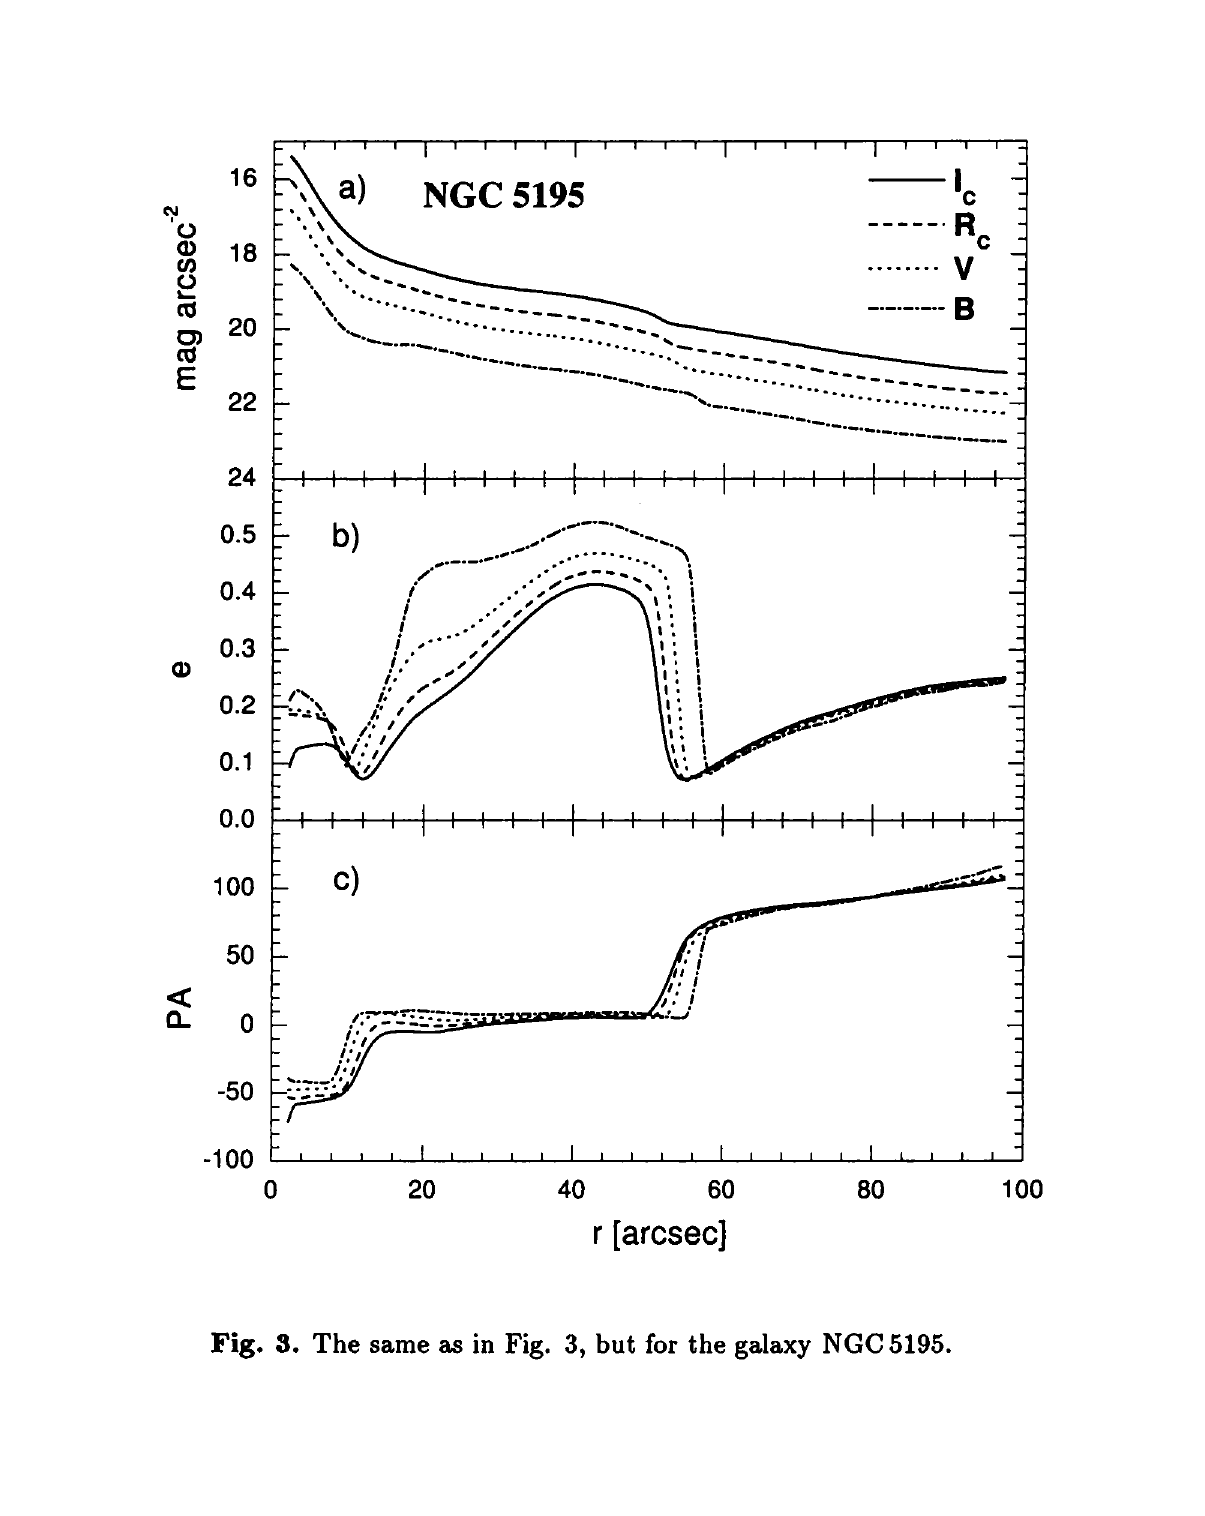
Fig. 3. The same as in Fig. 3, but for the galaxy NGC